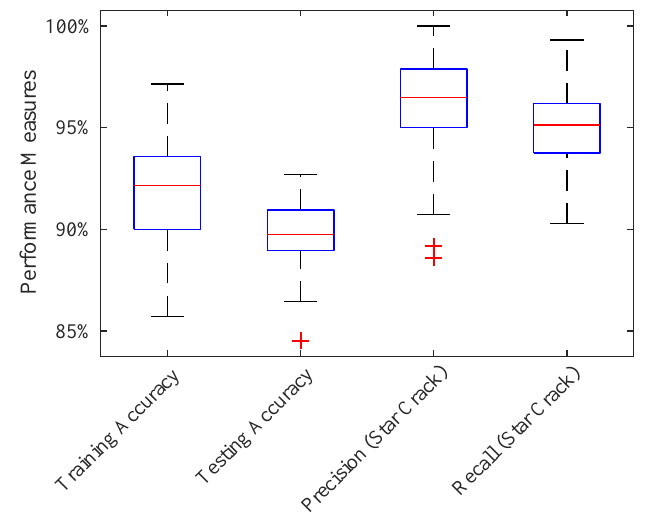
Figure 6. Performance measures of 100 times trained the simple